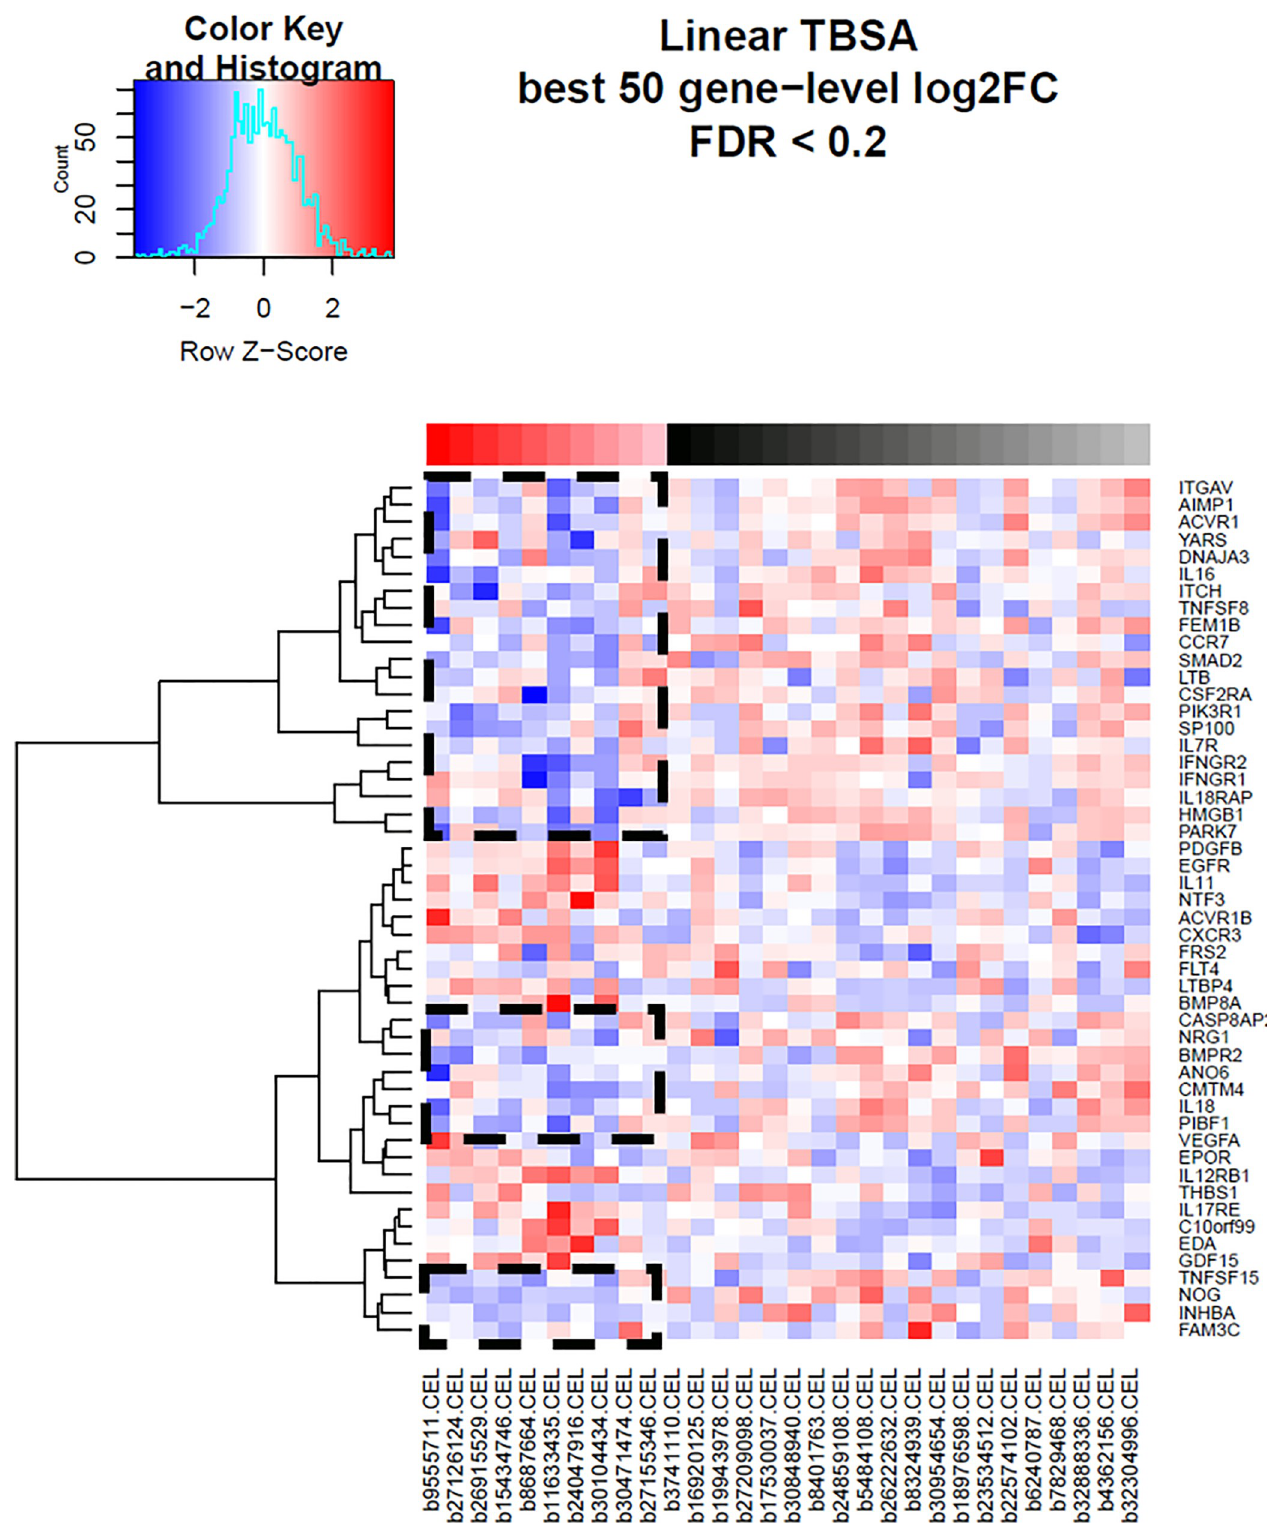
Fig 4. Heat map for comparison group 1 (TBSA as a linear covariate). Generated from hierarchical clustering of differentially expressed immune-related genes. The top colour blocks identify the sample type; red = elderly, black = adult, and shading corresponds to TBSA values. The color key outlines the degree of expression for each listed. gene. Boxed areas highlight downregulated genes in the elderly group. https://doi.org/10.1371/journal.pone.0226425.g004 PLOS ONE | https://doi.org/10.1371/journal.pone.0226425 December13,